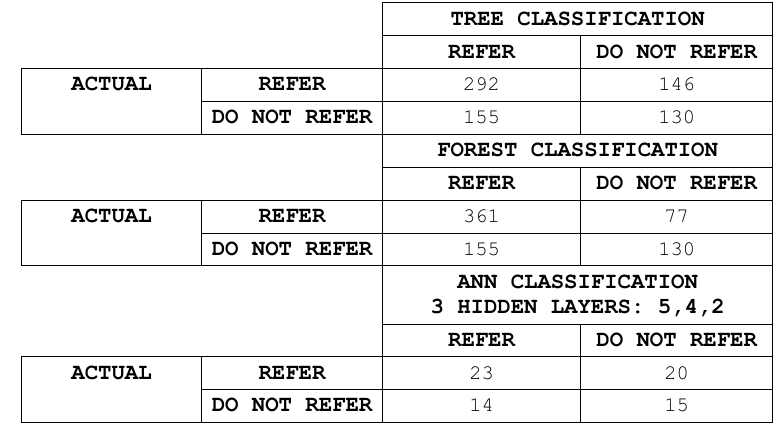
Table 2. Pixel value results.